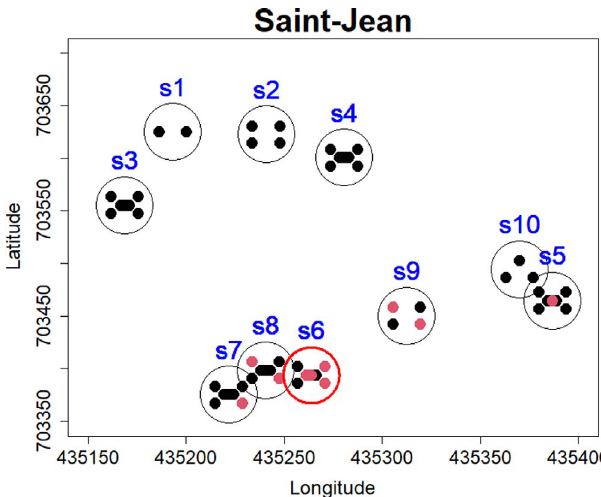
Figure 2. Spatial clustering of T. gondii -infected small mammals of Cotonou. Each black circle corresponds to a sampled site graphically represented by its GPS coordinates. Red and black dots represent T. gondii -infected and T. gondii -uninfected animals, respectively. Red circles represent signi fi cant clusters of cases based on the spatial statistic